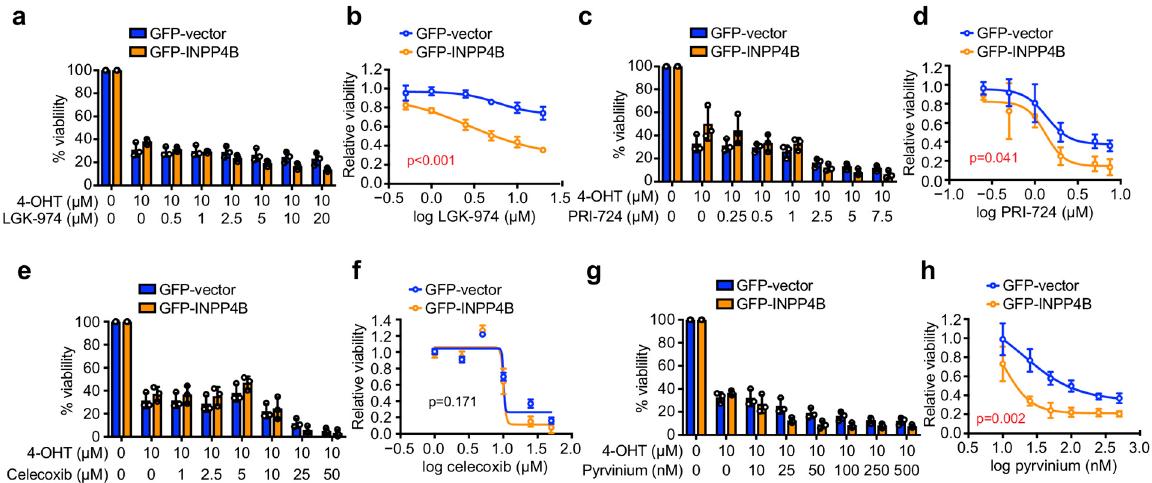
Figure 3. INPP4B ‐ overexpressing MCF ‐ 7 cells are more sensitive to 4 ‐ OHT ‐ pyrvinium combination Figure 3. INPP4B-overexpressing MCF-7 cells are more sensitive to 4-OHT-pyrvinium combination treatment in monolayer culture. MCF ‐ 7 cells expressing GFP ‐ vector or GFP ‐ INPP4B were treated treatment in monolayer culture. MCF-7 cells expressing GFP-vector or GFP-INPP4B were treated with 10 μ M 4 ‐ OHT ± 0.5–20 μ M LGK ‐ 974 ( a , b ), 0.25–7.5 μ M PRI ‐ 724 ( c , d ), 1–50 μ M celecoxib ( e , f ), with 10 µ M 4-OHT ± 0.5–20 µ M LGK-974 ( a , b ), 0.25–7.5 µ M PRI-724 ( c , d ), 1–50 µ M celecoxib ( e , f ), 10–500 nM pyrvinium ( g , h ) or DMSO as a vehicle control for 48 h, then cell viability was assessed using CellTiter-Glo ® assays. Data represent the relative cell viability normalized to untreated cells ( a , c , e , g ), or plotted as a 4-parameter logistical regression normalized to 4-OHT-treated cells ( b , d , f , h ) ± SD ( n = 3 experiments). p values were determined by two-tailed unpaired t test of the area under the curve in ( b , d , f , g